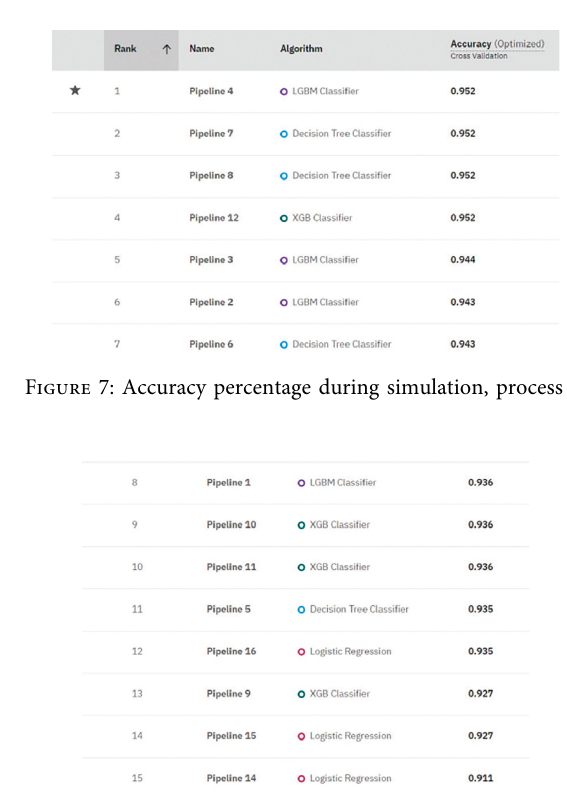
Figure 8: Accuracy percentage during simulation, process 2.